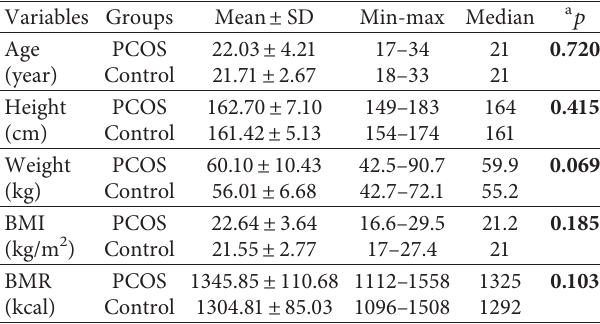
Table 1: Evaluation of some anthropometric measurements of PCOS and the control group.